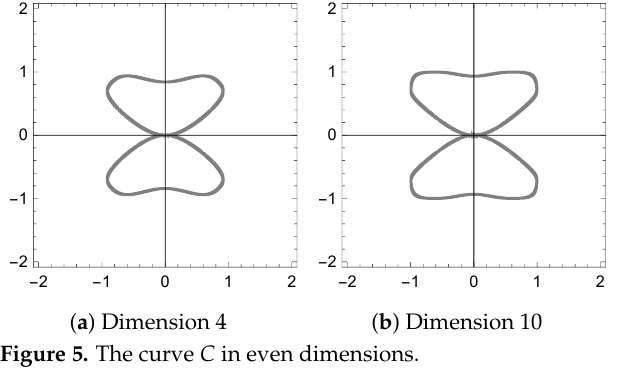
Figure 5. The curve C in even dimensions.